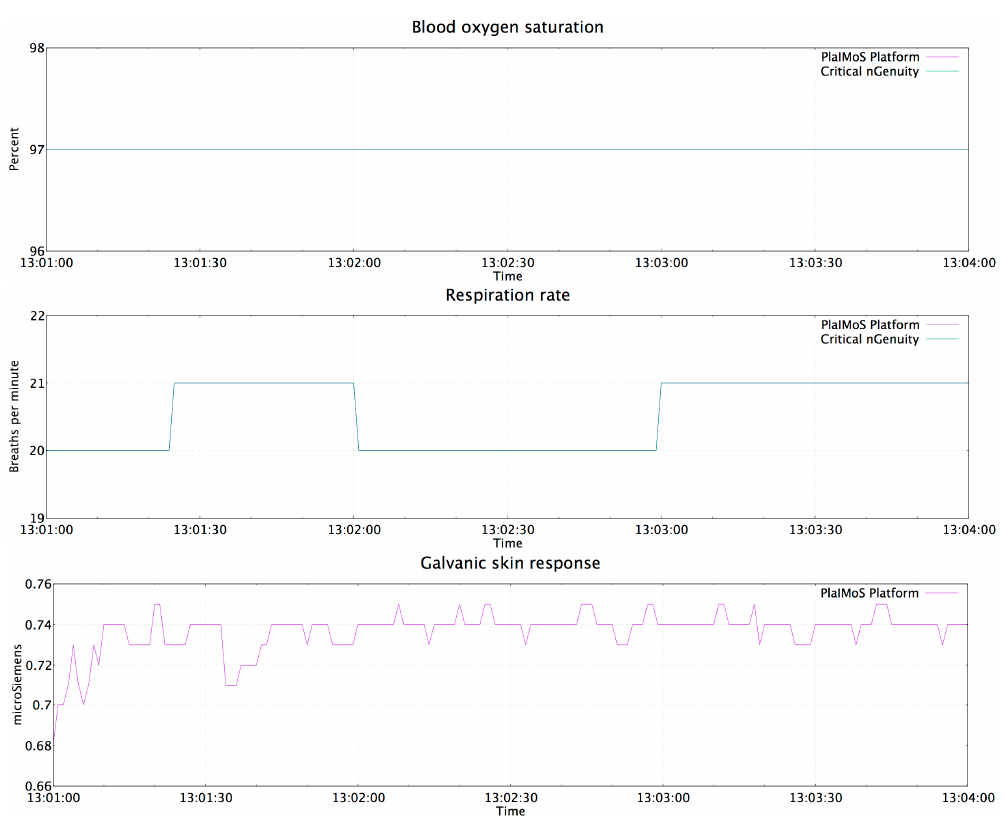
Figure 20. Values obtained by the PlaIMoS fixed measurement station.